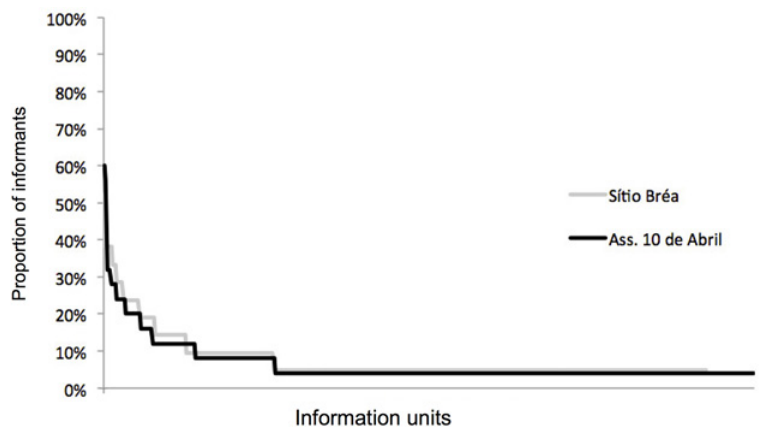
Fig 4. Rate of sharing of information units (therapeutic target — medicinal plant) among local experts from two rural communities in the semi-arid region of northeastern Brazil.